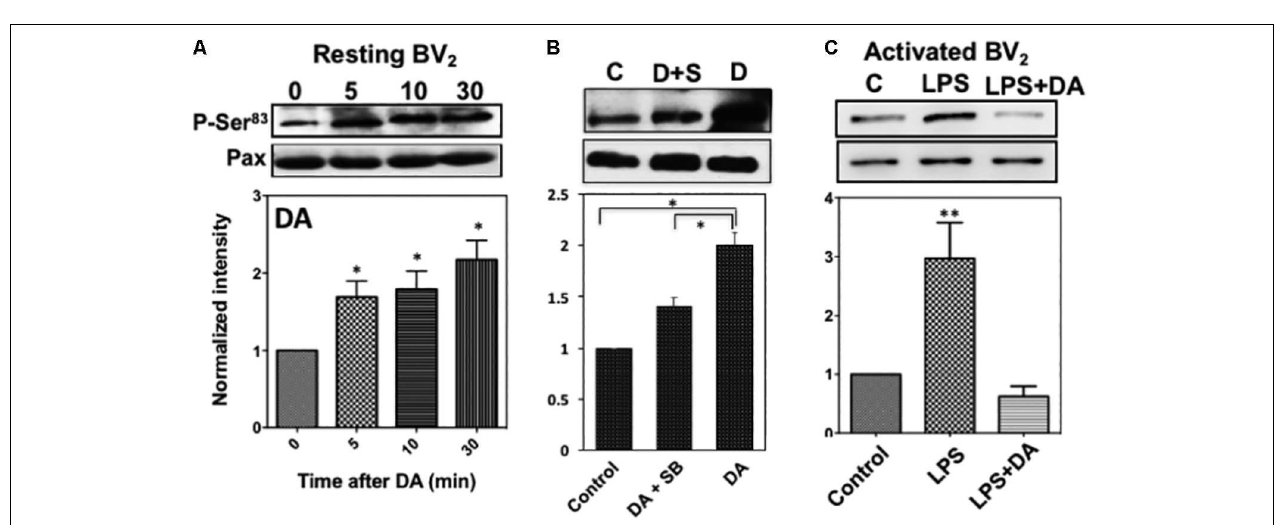
FIGURE 7 | (A) Phosphorylation of paxillin at Ser 83 via the activation of p38MAPK in resting microglia in response to DA. Paxillin phosphorylation was detected by immunoblots with the anti-phospho-paxillin Ser 83 antibody. Immunoblots with anti-paxillin antibody were used as a loading control. Representative images of western blots for the phosphorylation of paxillin at Ser 83 are shown. Values are means ± standard error of four independent experiments (ANOVA: ∗ P < 0.05). (B) Inhibition of Ser 83 phosphorylation by the p38MAPK inhibitor. Resting Bv2 microglia cells were pre-treated with 0.5 µ M SB203580 (p38MAPK inhibitor) for 10 min and then 2 µ M DA for 30 min. Values are means ± standard error of three independent experiments (ANOVA: ∗ P < 0.05). (C) DA downregulates paxillin phosphorylation at Ser 83 in activated microglia (ANOVA: ∗∗ P <